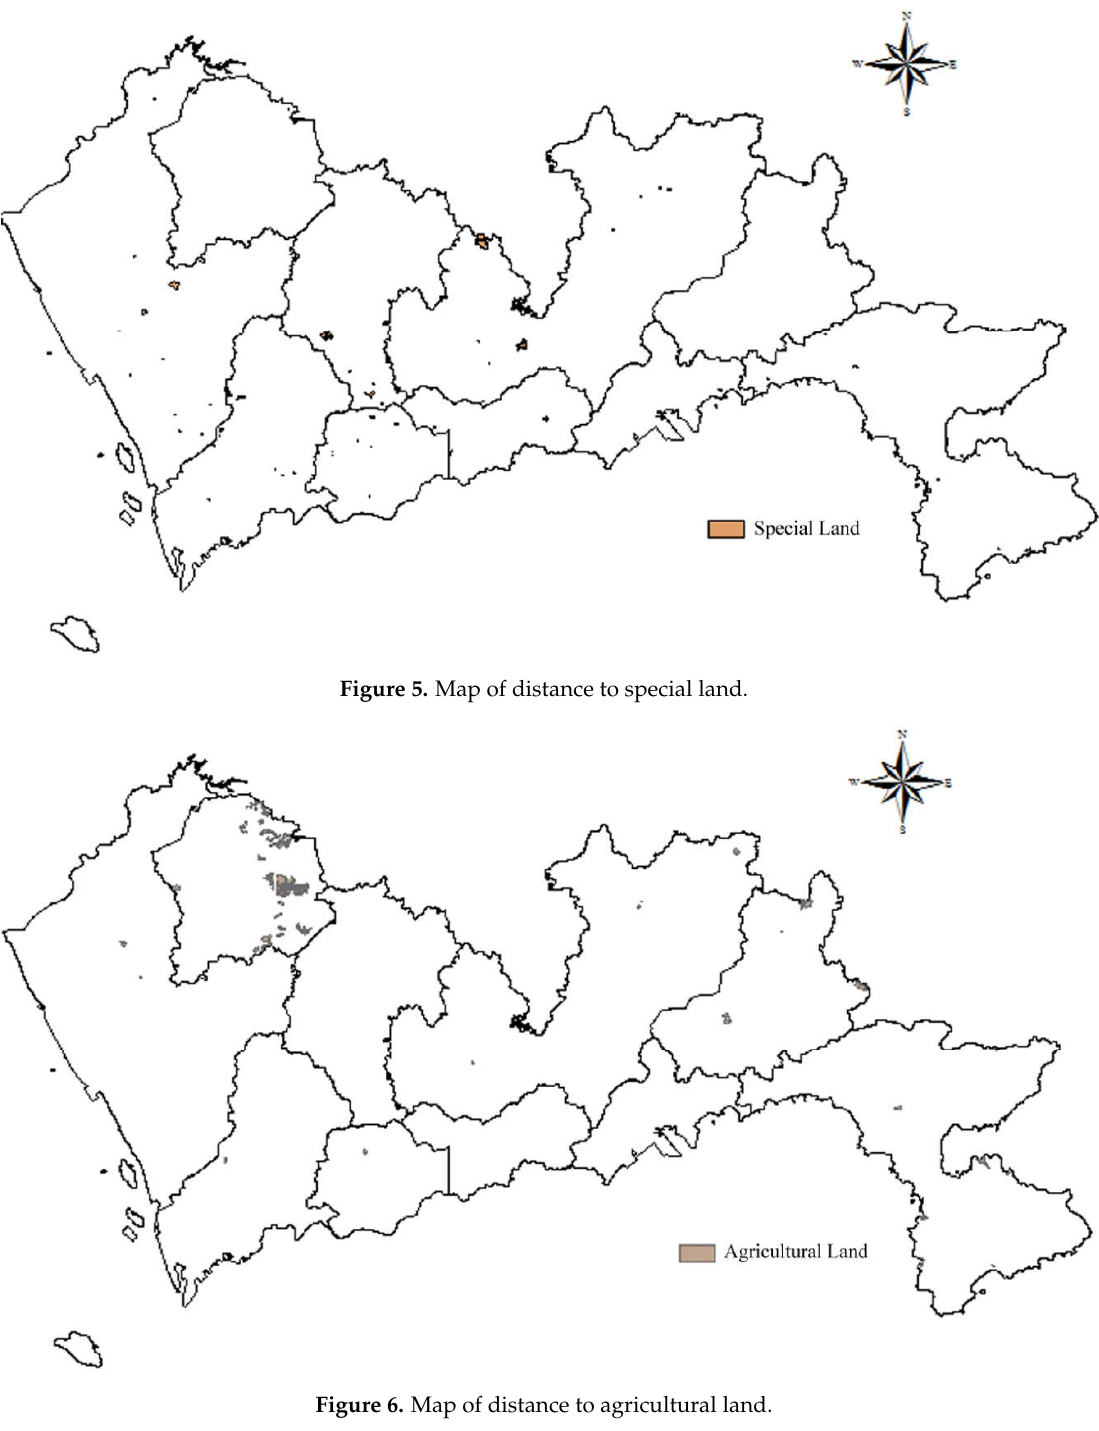
Figure 6. Map of distance to agricultural land.